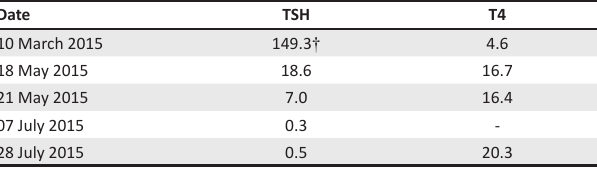
TABLE 1: Serial thyroid function tests that show the hypothyroid state before the computed tomography scan and the hyperthyroidism that developed after the computed tomography